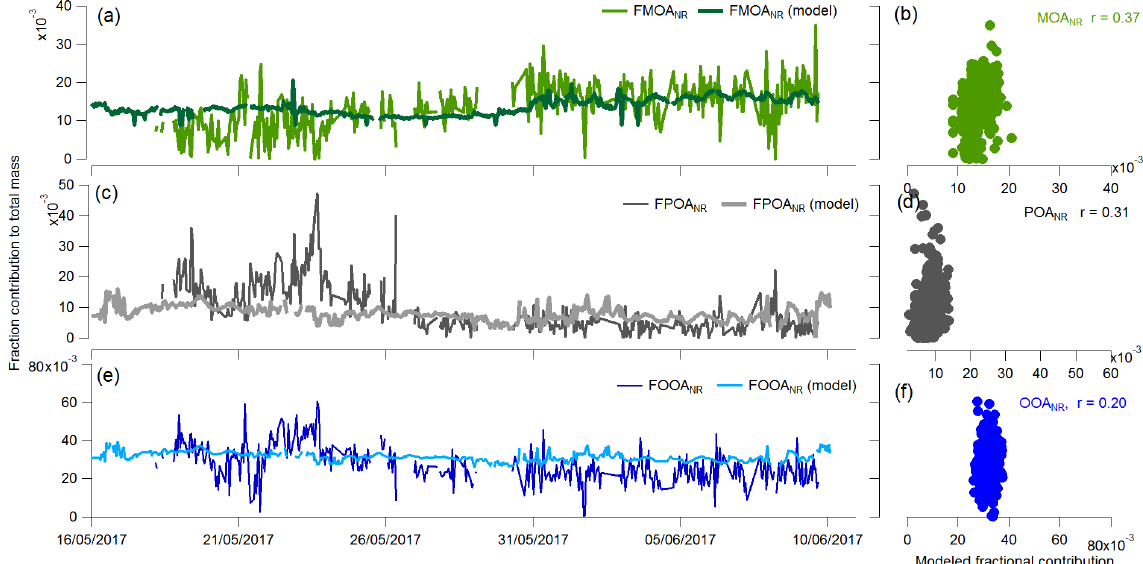
Figure 8. Time series and correlation plots of each of the parameterizations (Eqs. 4 to 6) for the determination of the different organic fractions in nascent